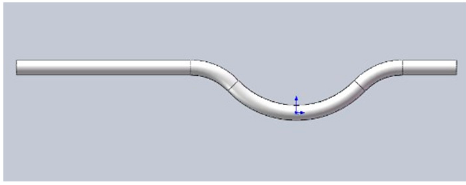
Figure 2. The geometric model of numerical simulation.